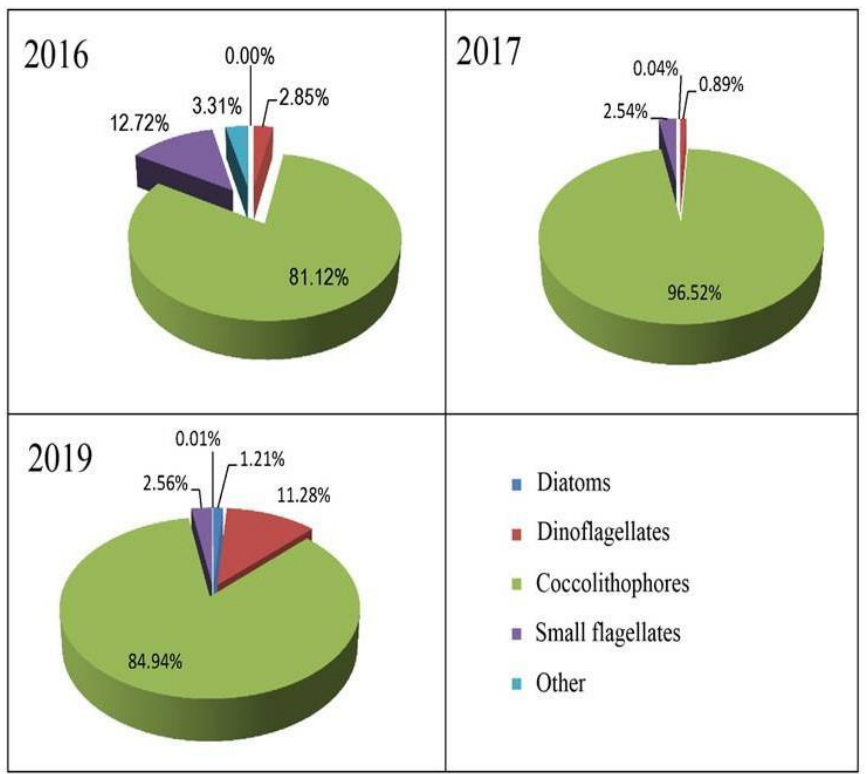
Figure 5. Taxonomic composition of phytoplankton biomass at the end of spring and in the early summer during the period of bloom of Emiliania huxleyi in 2016, 2017, and 2019.